Question: Express in one sentence what the figure is showing.
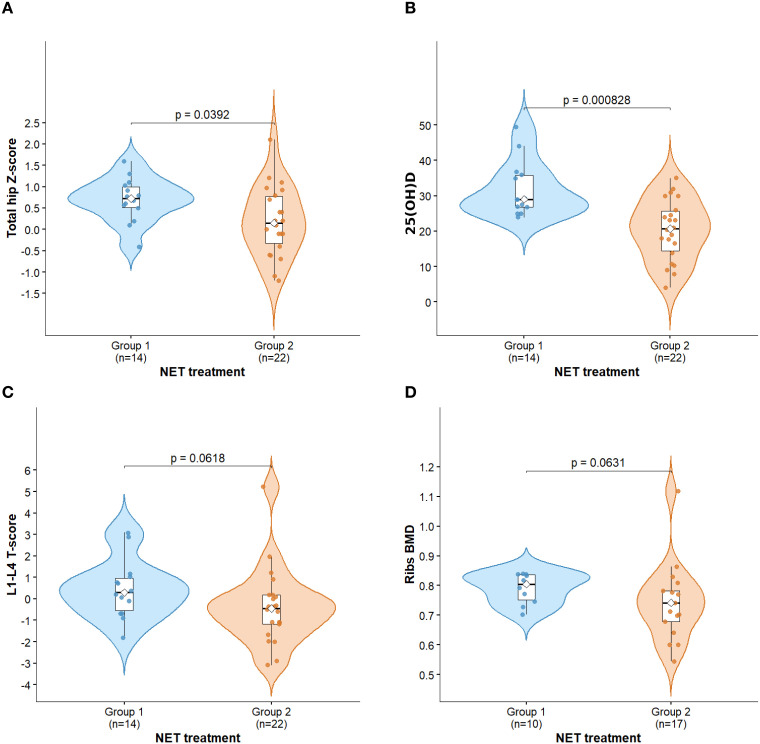
Answer: Violin plots showing the comparison between group 2 (somatostatin analogues/radioligand therapy after surgery) and group 1 (surgical treatment alone) regarding (A) total hip Z-score; (B) 25(OH)D (25-hydroxyvitamin D); (C) L1-L4 T-score and (D) ribs bone mineral density (BMD). Statistical comparisons are reported with the corresponding p-values.